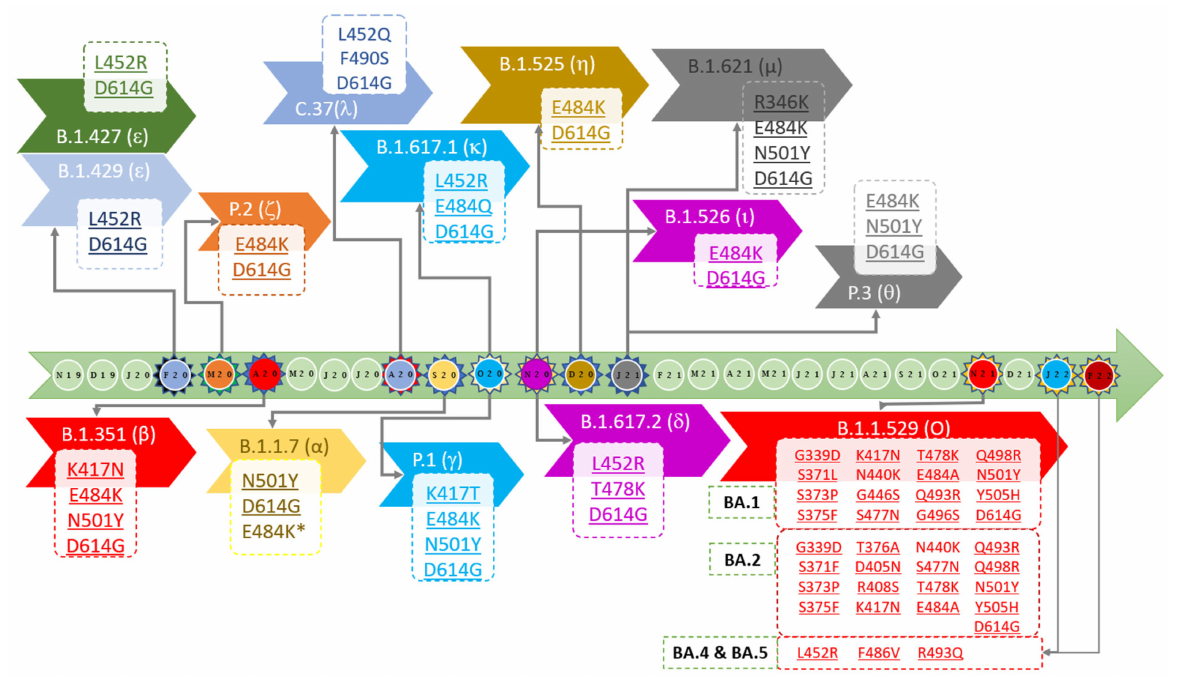
Figure 1. Timeline of various SARS-CoV-2 mutations observed across the Pango lineages. The WHO- proposed naming scheme is shown in brackets. The light green central arrow indicates the progress bar, and each circle represents a month, starting from November 2019 to February 2022. The circles with spike-like projections represent the month of the first appearance of new important lineages. Each chevron arrow is for individual lineages; the rectangle boxes contain the information about the key spike RBD mutations (* only in the B.1.1.7 sub lineage). Information on the previous and current WHO variants of concern are represented under the central progress bar, whereas previous variants of interest or under monitoring are above the